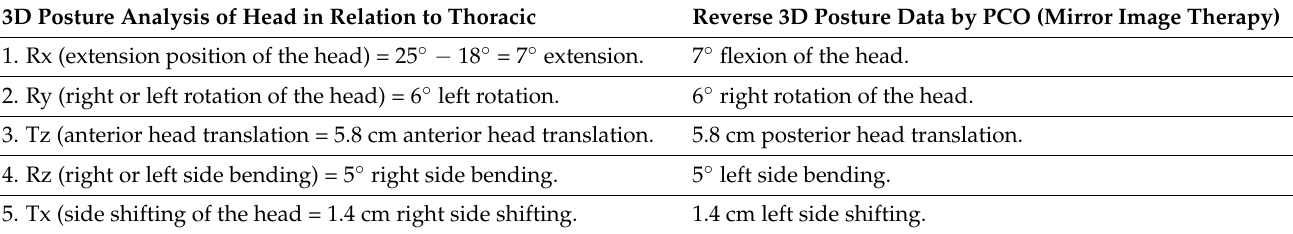
Table 2. Example of 3D posture analysis data and mirror image therapy (reverse posture training) using the posture corrective orthotic